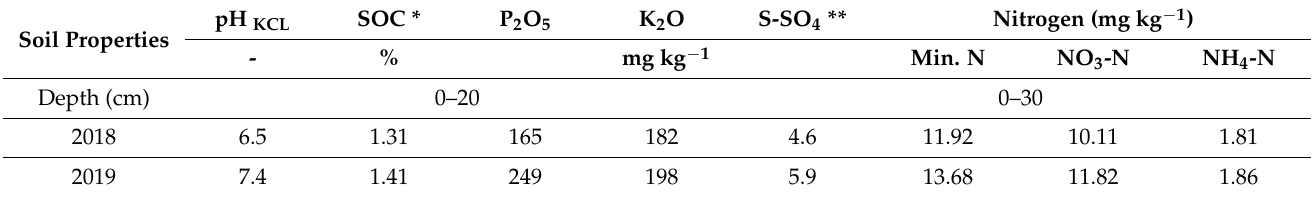
Table 1. Soil chemical characteristics before using fertilizers in 2018 and